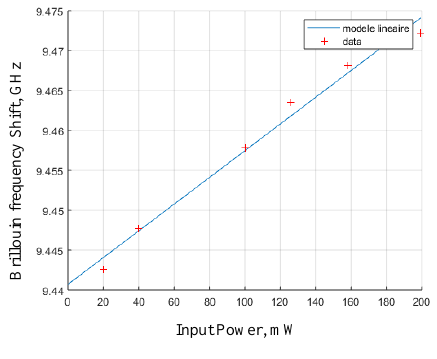
Fig. 4 Brillouin frequency shift measurement as a function of cw input power at 1550nm for a diameter of nanofiber of 940 nm and a length of 40